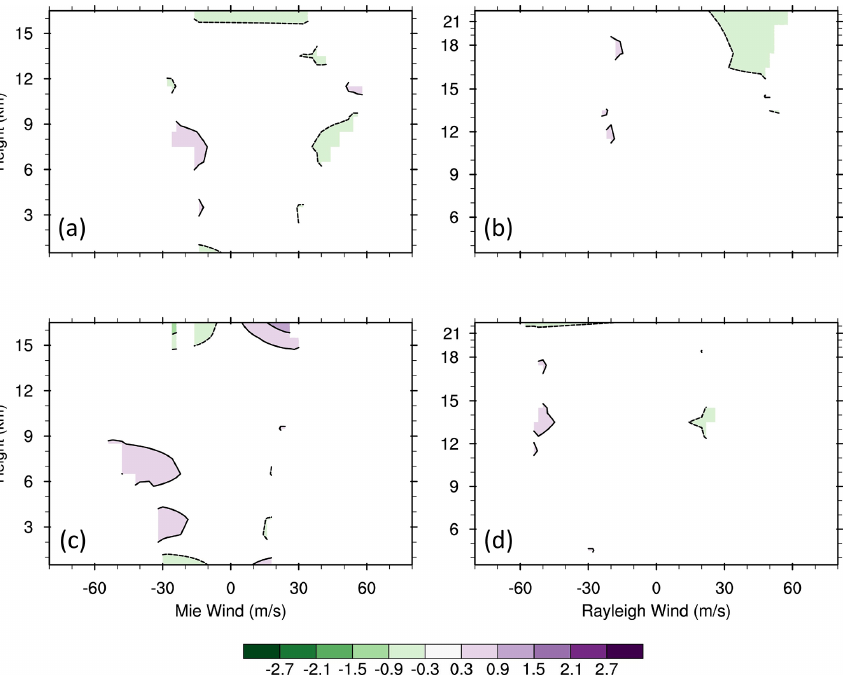
Figure 14. As in Fig. 8 but for the mean innovation after the TLS bias correction is applied. For each 6h cycle during 1–7 September 2019, the TLS bias correction is calculated from the 28 preceding 6h